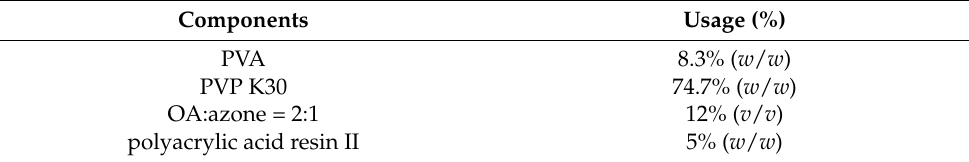
Table 6. LP-VPH compound transdermal drug delivery system optimized